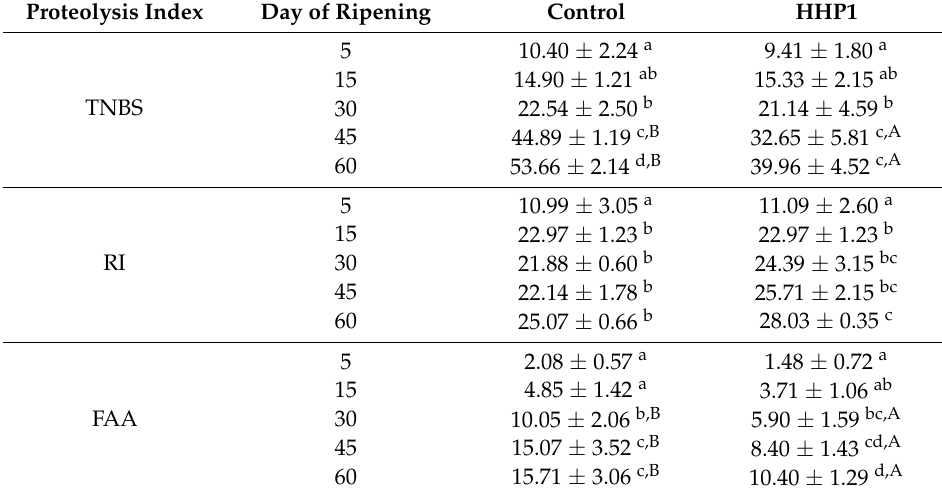
Means with different superscript small letter differ significant ( p < 0.05) in the same column for the same parameter and HHP treatment; means with different superscript capital letter differ significant ( p < 0.05) in the same row for the same parameter and day of